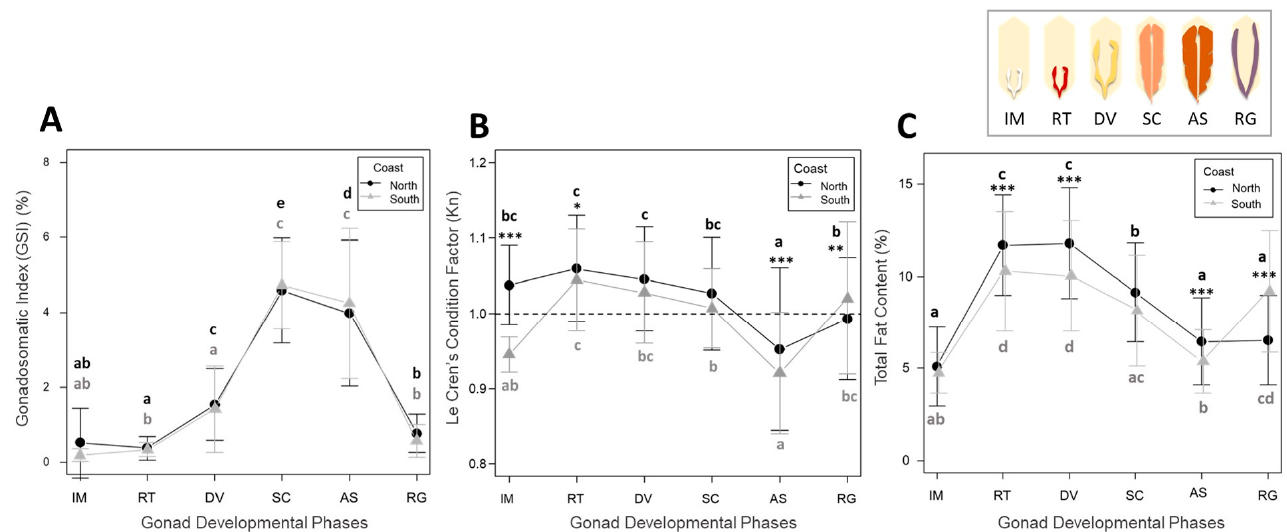
Figure 3. ( A – C ) The gonadosomatic index (GSI) (%), Le Cren’s condition factor (Kn), and total fat content during the annual reproductive cycle, comparing sardines caught on the northern Catalan Coast with the ones caught on the southern Catalan Coast. Gonad developmental phases: IM, imma- ture; RT, regenerating; DV, developing; SC, spawning capable; AS, actively spawning; RG, regressing. Significance values were indicated as follows: p < 0.05 *; p < 0.001 **; p < 0.0001 ***. Lowercase letters indicate differences in GSI, Kn and total fat content throughout the gonad developmental